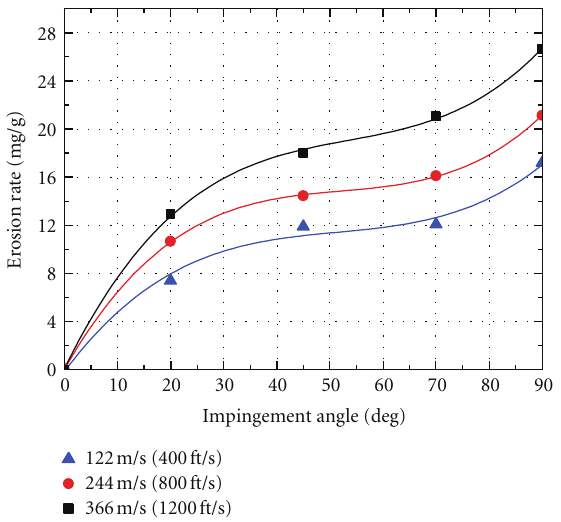
Figure 8: TBC erosion rates by 26 μ m alumina particles at 871 ◦ C (1600 ◦